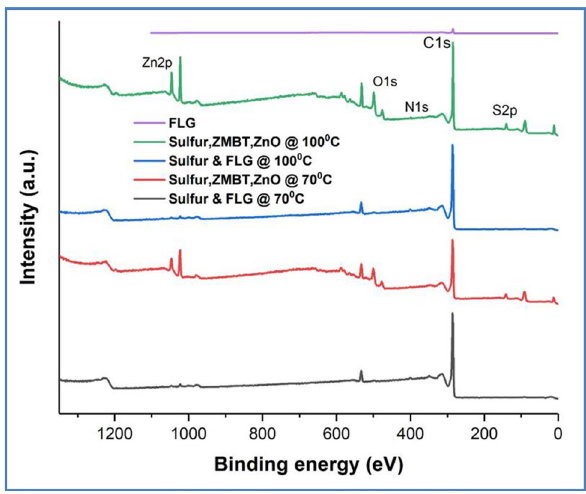
Figure 3. XPS survey spectra for FLG, control experiments (Sulfur and FLG) performed at 70 and 100 °C and the purified products from the model